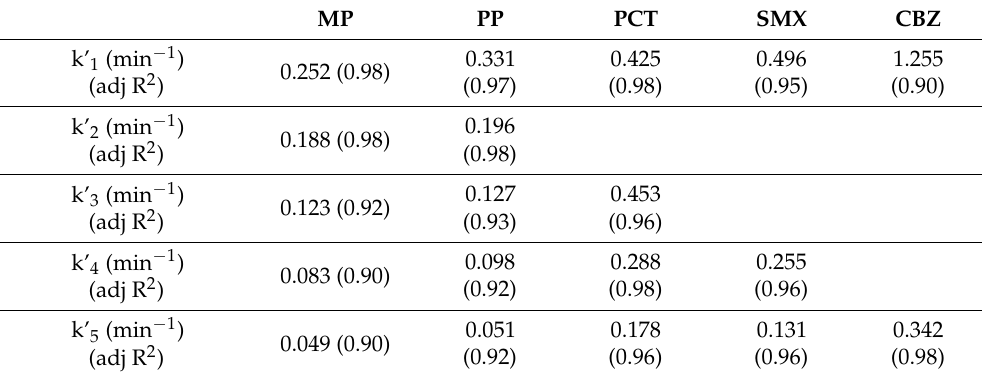
Table 4. Pseudo-first order kinetic rate constant of ozone-treated contaminants, in mixture as function of time.(k’ 1 ) refers to the PPCP individually, whereas k’ 2 , k’ 3 , k’ 4 , and k’ 5 , refer to Mix.2, Mix.3, Mix.4 and Mix. 5, respectively. The corresponding adjusted coefficients of determination (adj R 2 ) are also presented. MP